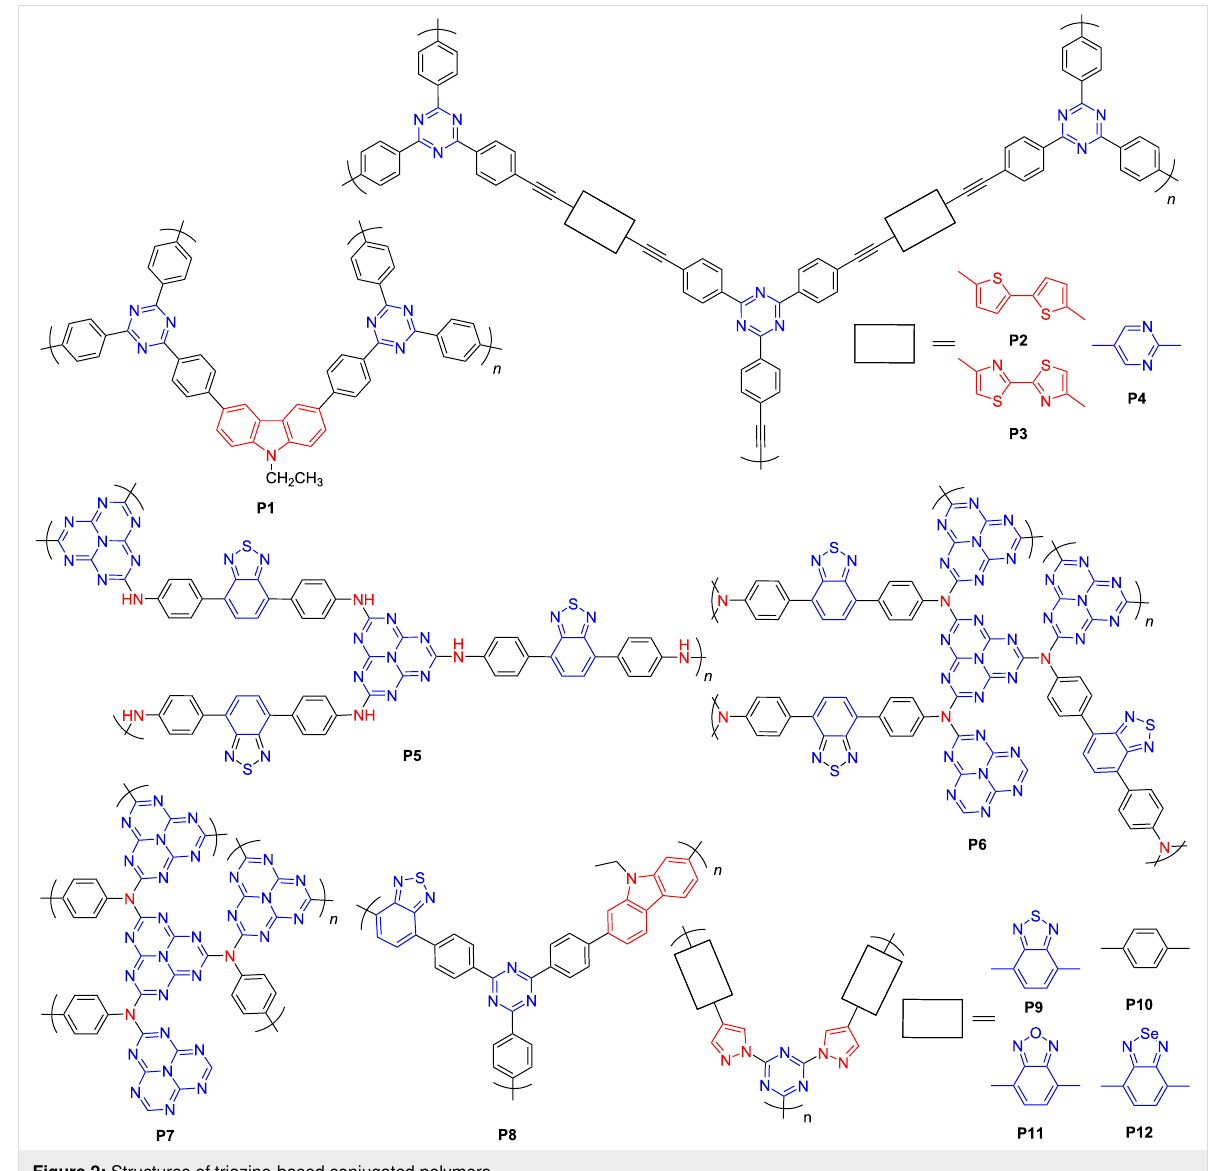
Figure 2: Structures of triazine-based conjugated polymers.